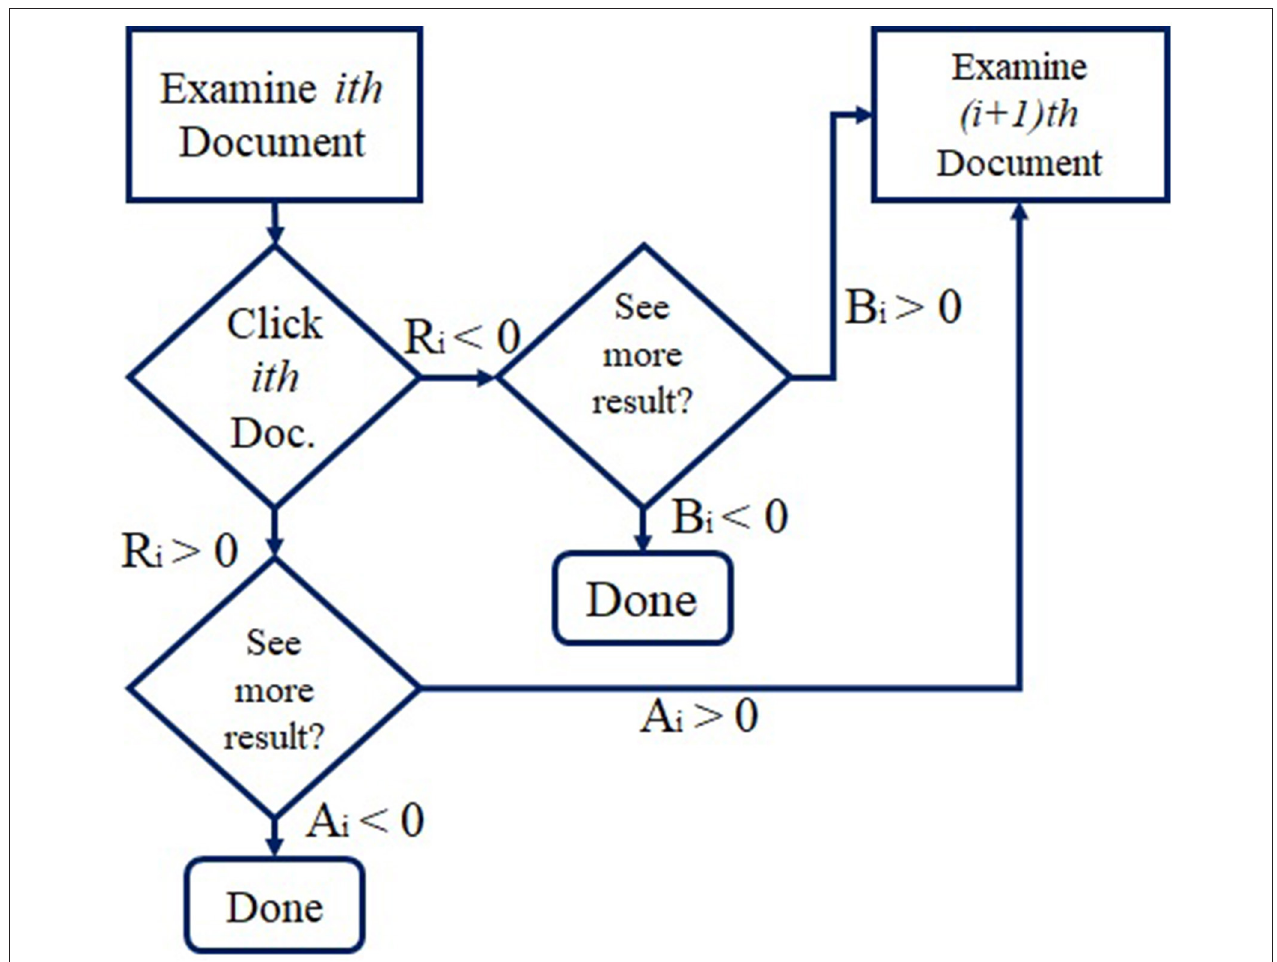
FIGURE 4 | User flow chart